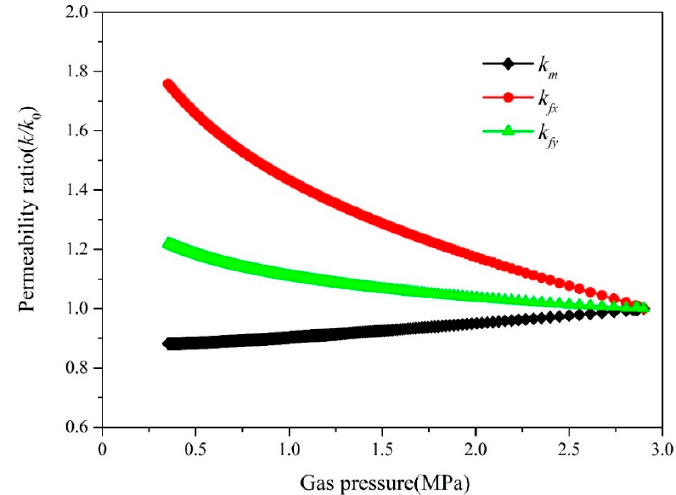
Figure 8. The evolution of the matrix and fracture permeability at a specific point x = 9 m and y = 5.5 m during gas drainage.